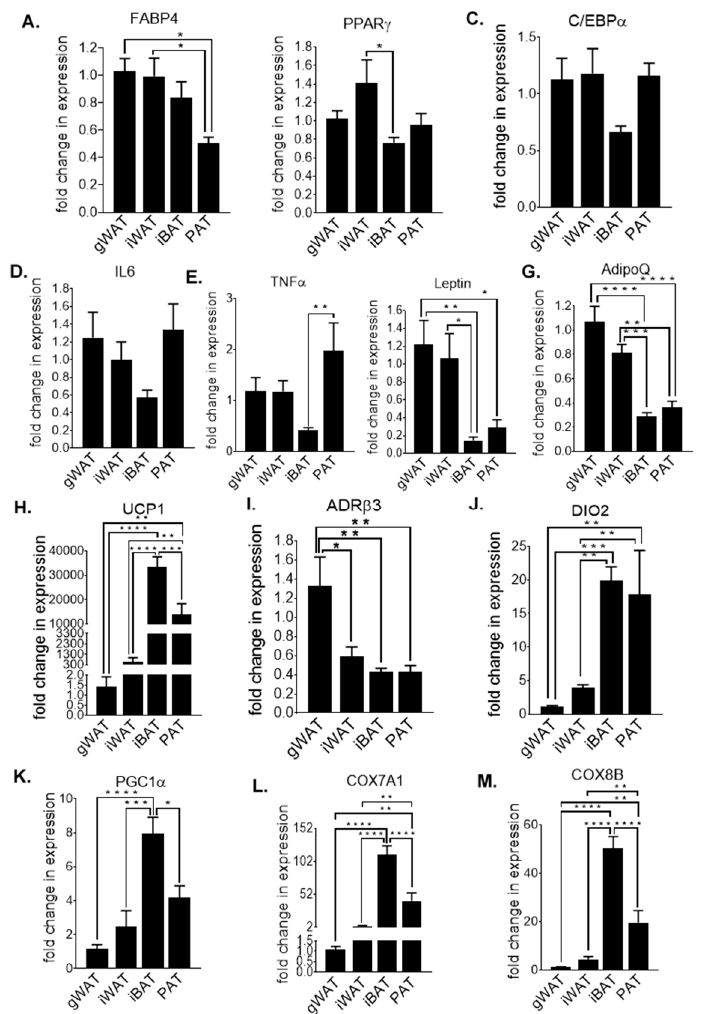
Figure 2. FABP4 ( A ), PPAR γ ( B ), C / EBP α ( C ), IL6 ( D ), TNF α ( E ), Leptin ( F ), AdipoQ ( G ), UCP1 ( H ), ADR β 3 ( I ), DIO2 ( J ), PGC1 α ( K ), COX7A1 ( L ) and COX8B ( M ) fold change in mRNA expression in gWAT, iWAT, iBAT and PAT of chow (C)-fed 30-week-old mice. All data are relative to the